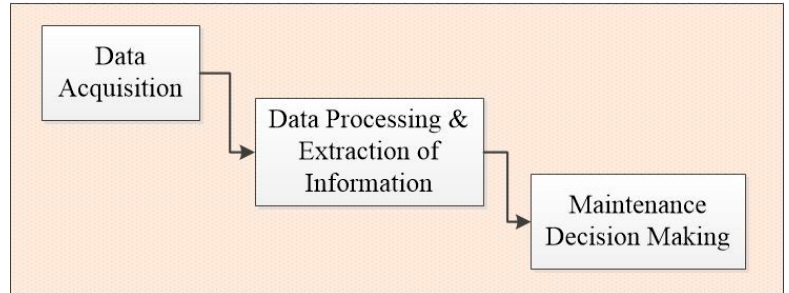
Figure 1. Condition Based Maintenance process.